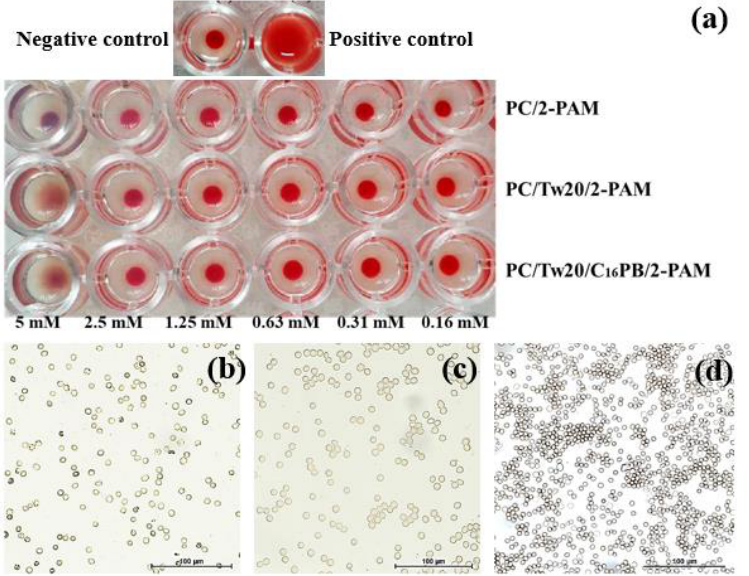
Figure 5. ( a ) Photograph of microplate wells containing blood samples with addition of unmodi- fied and modified transfersomes. Agglutination of erythrocytes observed using transmitted light microscopy with the addition of: ( b ) PC/Tw20/2-PAM; ( c ) PC/Tw20/C 16 PB/2-PAM 1/0.2/0.025; ( d ) positive control of agglutination.